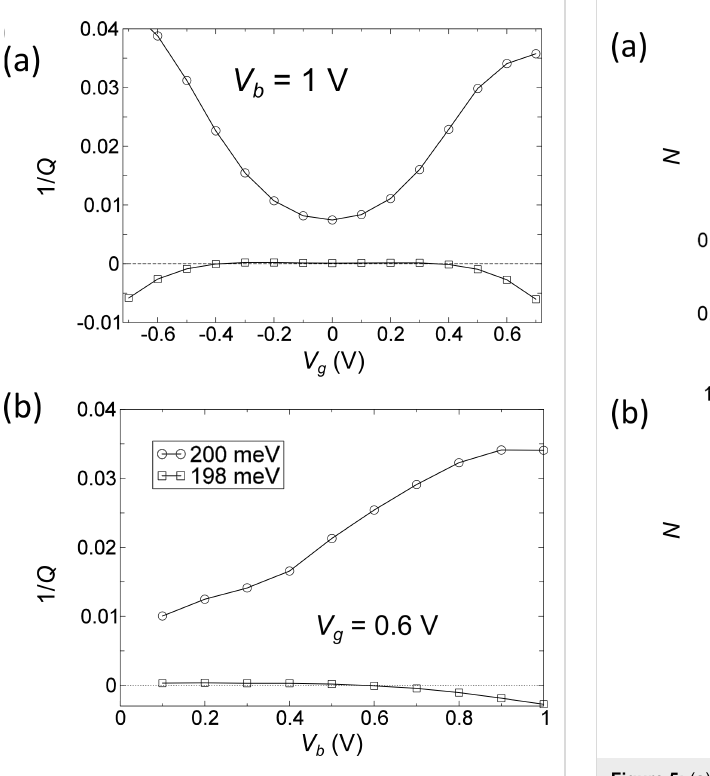
Figure 4: (a) Inverse Q-factor (1/ Q ) as a function of gate voltage, V g , at V b = 1 V for the two modes around 200 meV. (b) 1/ Q as a function of bias voltage, V b , at fixed gate voltage V g = 0.6 V, for the same pair of phonon modes.